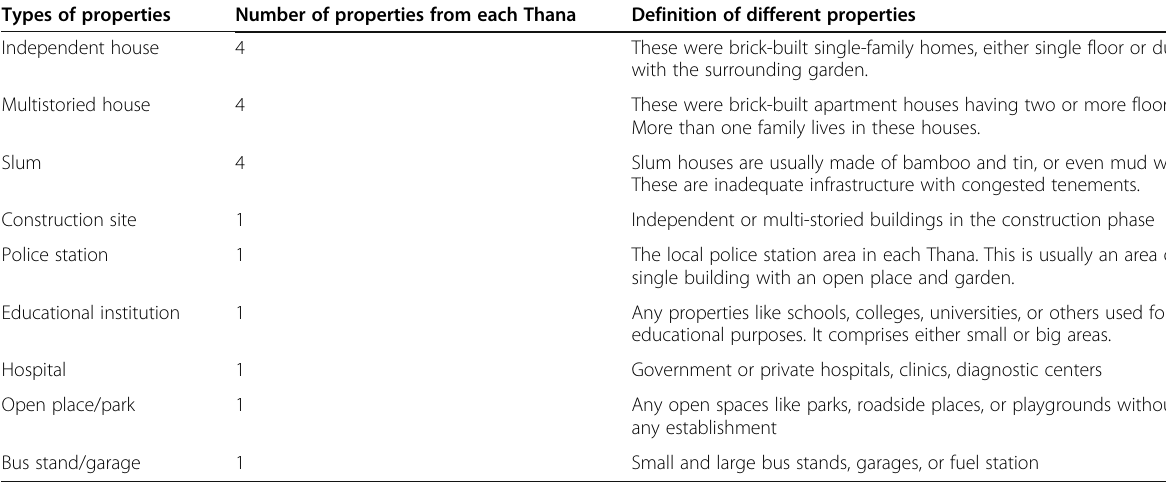
Table 1 Number and type of properties surveyed in each Thana Types of